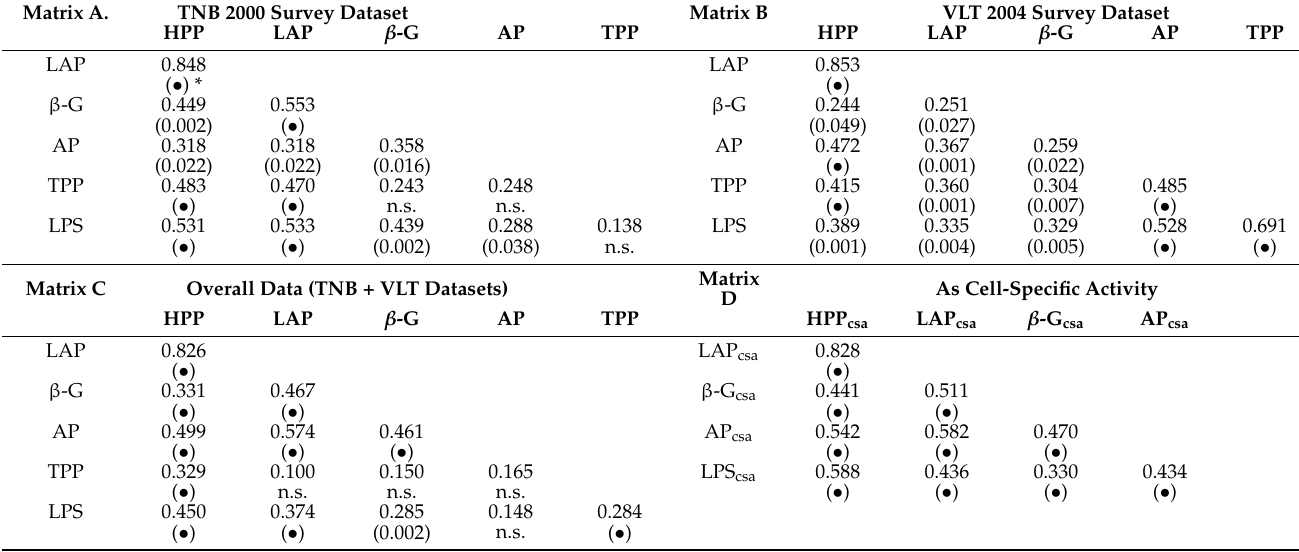
Table 2. Spearman’s rho correlation coefficients calculated between the log 10 -transformed values of heterotrophic prokaryotic production (HPP, as ngC L − 1 h − 1 ) and exoenzymatic activities (leucine aminopeptidase-LAP, alkaline phosphatase-AP, ß-glucosidase-ß-G) (as nM h − 1 ), total picoplankton- TPP (as cells L − 1 ), and lipopolysaccharide-LPS (as ng L − 1 ). For the matrix D, the correlations were calculated using the cell-specific activity (csa) values, reported as nmol cell − 1 h − 1 for enzyme activities and as ag cell − 1 for